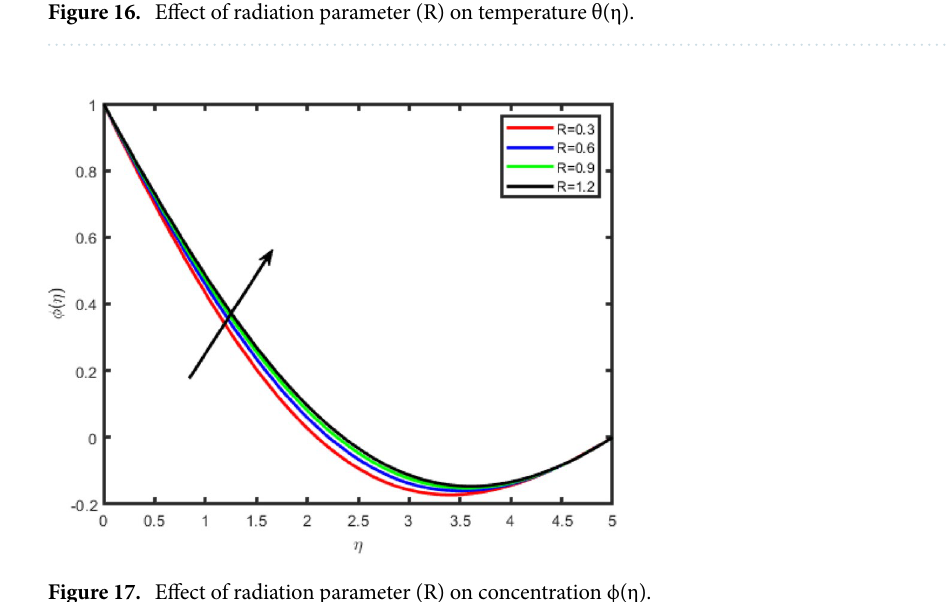
Figure 17. Effect of radiation parameter (R) on concentration ϕ(η).